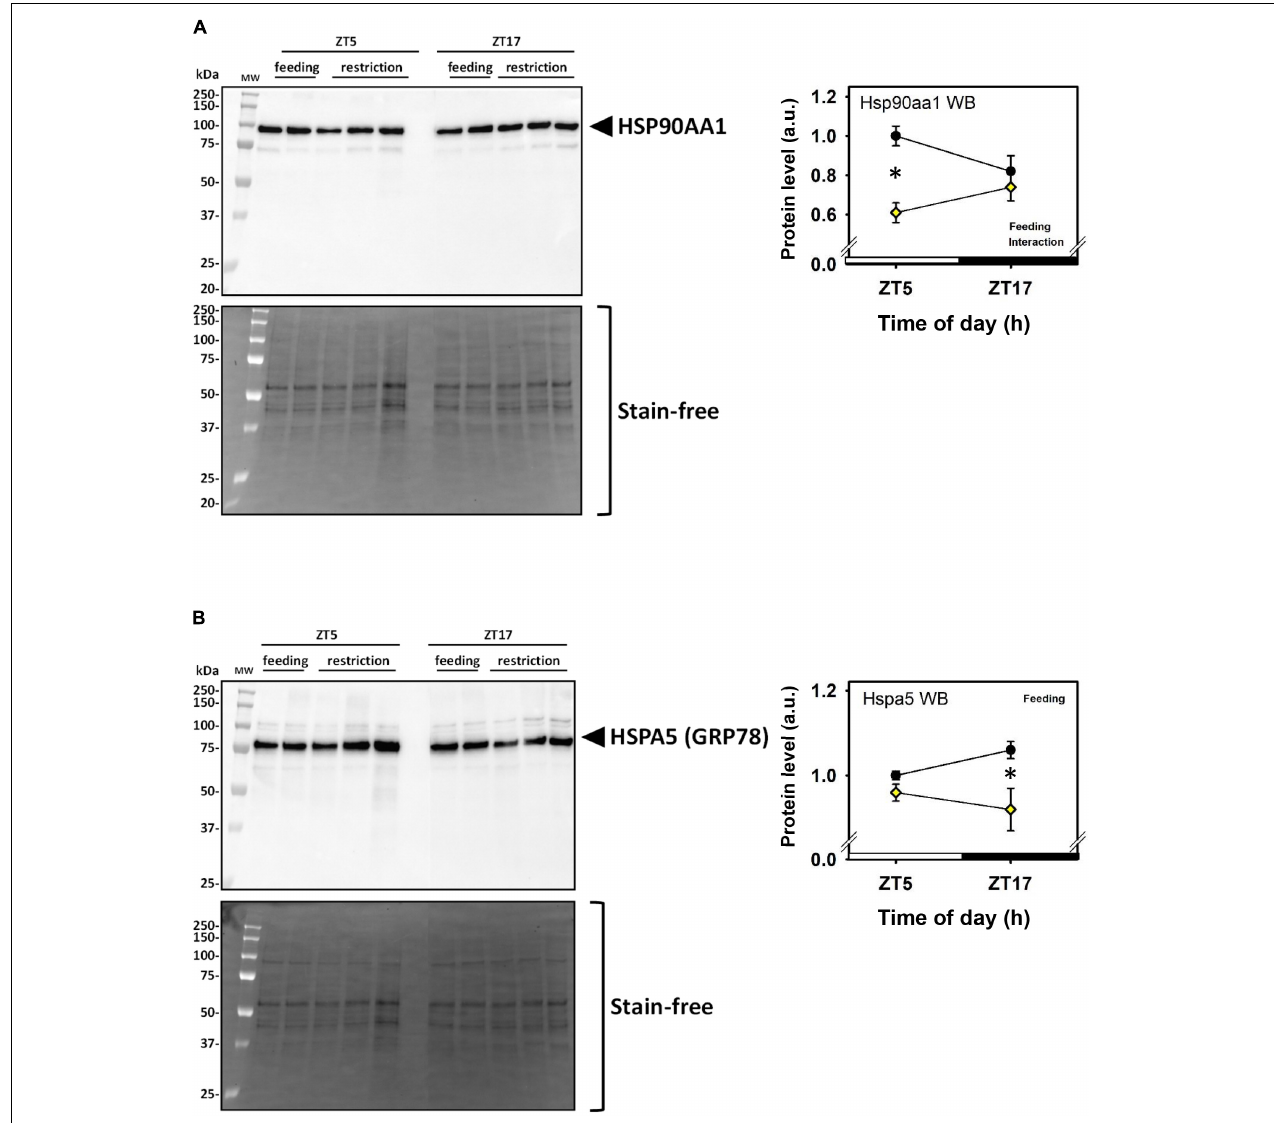
FIGURE 8 | Day–night expression of cerebellar proteins affected by feeding assessed by Western blots. (A) Representative Western blot (WB; left panel) and mean protein levels (right panel) for Hsp90aa1, to be compared with spot 1,085 of 2D-DIGE analysis (spots 1,085 and 1,087, see Figure 2 ). (B) Representative Western blot (WB; left panel) and mean protein levels (right panel) for Hspa5, to be compared with spot 1,085 of 2D-DIGE analysis (spot 610, see Figure 3 ). In the right panels, Feeding and Interaction indicate significant ( P < 0.05) main effects of feeding conditions or time-of-day × feeding interaction, respectively, as detected by two-way ANOVA (see section “Materials and Methods” for details). * P < 0.05 after post hoc Tukey